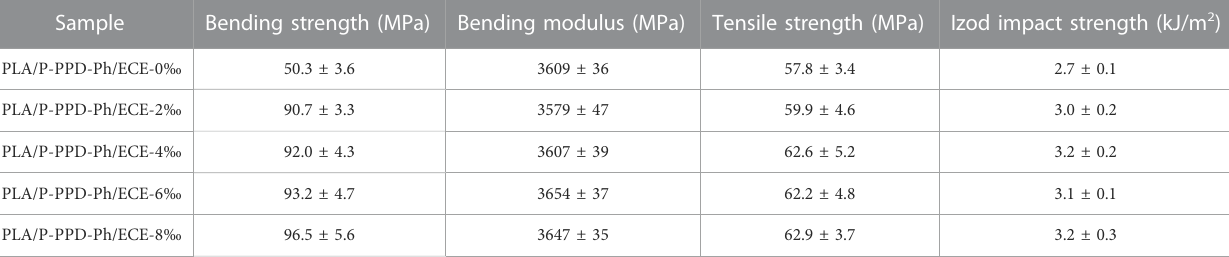
TABLE 5 Mechanical properties of PLA/P-PPD-Ph/ECE fl ame retardant composites.